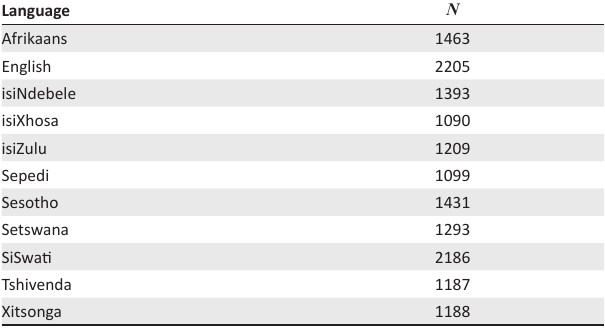
TABLE 1: Number of Grade 4 prePIRLS 2011 students tested by language.